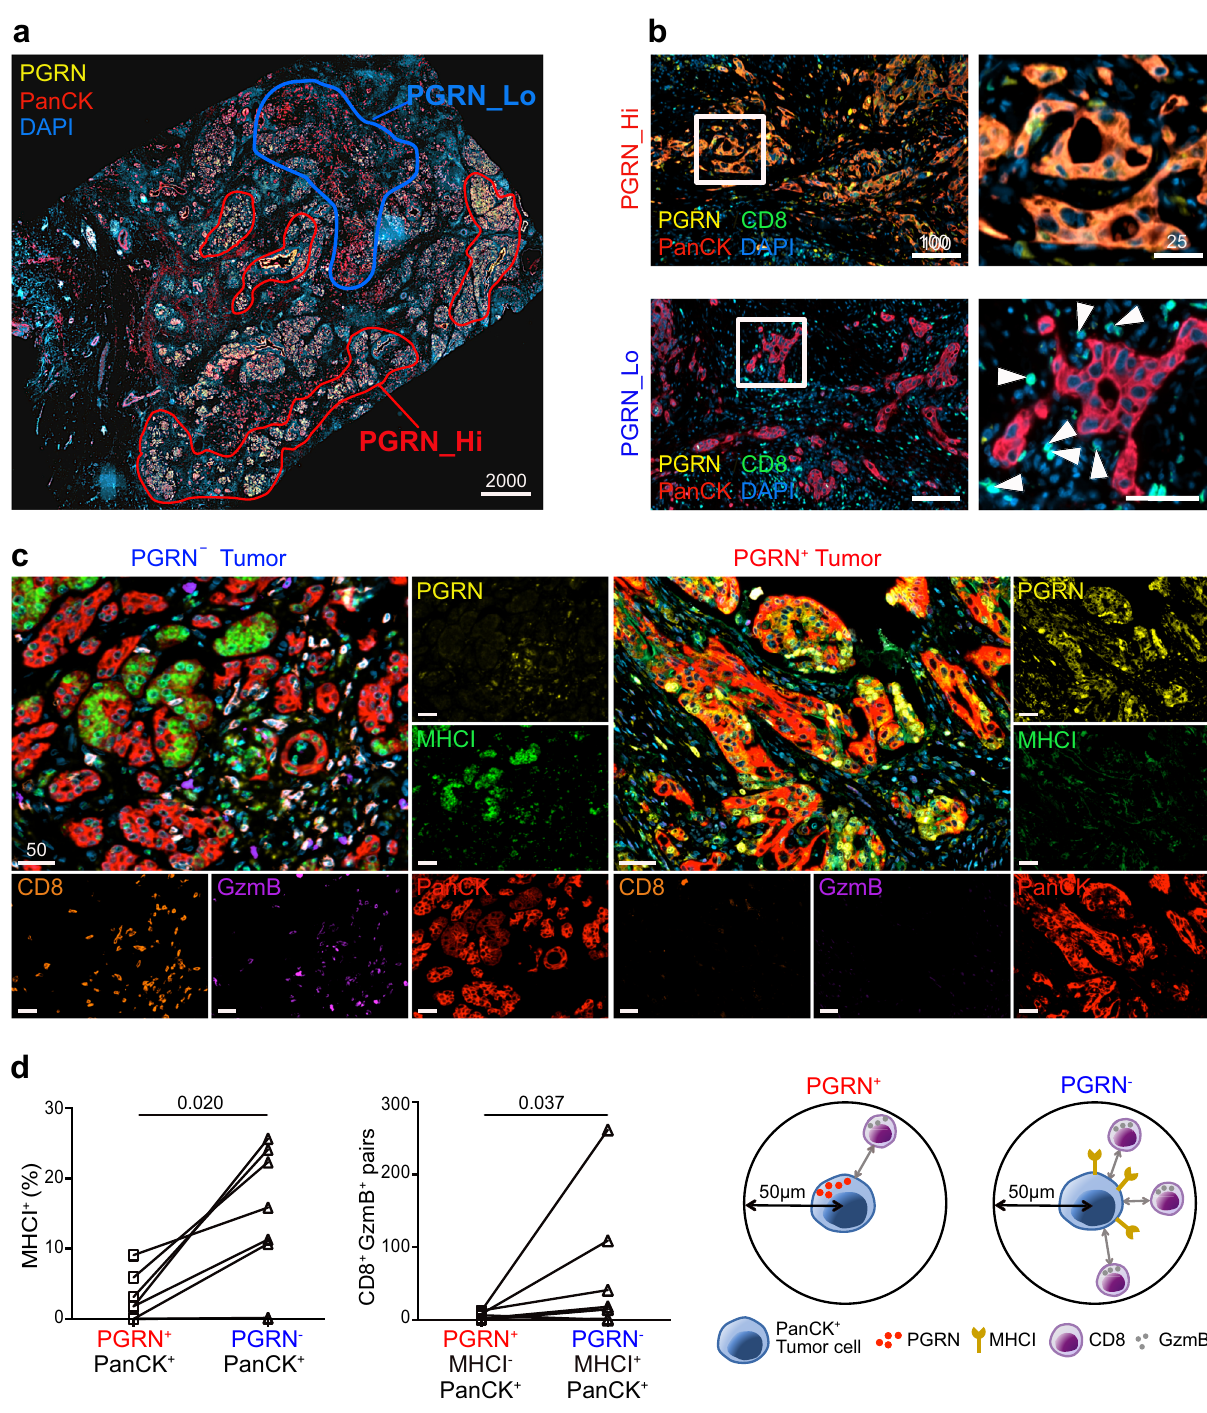
Fig. 2 PGRN + tumors of PDAC patients exhibit lower levels of MHCI expression and CD8 in fi ltration. a Representative mIF image demonstrates the intratumoral heterogeneity of PGRN expression in human PDAC, where high and low PGRN-expressing tumor regions were observed in the same specimen. ( n = 8). Representative images are shown. b mIF staining of PGRN (yellow), CD8 (green), and PanCK (red) in human PDAC shows increased CD8 in fi ltration in low PGRN-expressing tumor areas. ( n = 8). Representative images are shown. c Differential MHCI (HLA-A) expression in PGRN + and PGRN − tumors, and the in fi ltration of GzmB + CD8 + cells in their corresponding neighborhoods. ( n = 8). Representative images are shown. d Automated computational analysis showing the percentage of MHCI + cells in PGRN + PanCK + and PGRN − PanCK + tumor populations, and the number of CD8 − GzmB − cells in proximity (<50 μ M radical distance) of PGRN + MHCI − or PGRN − MHCI + PanCK + tumor cells in human PDAC ( n = 8). Two-tailed Mann – Whitney test. Scale bar unit: μ